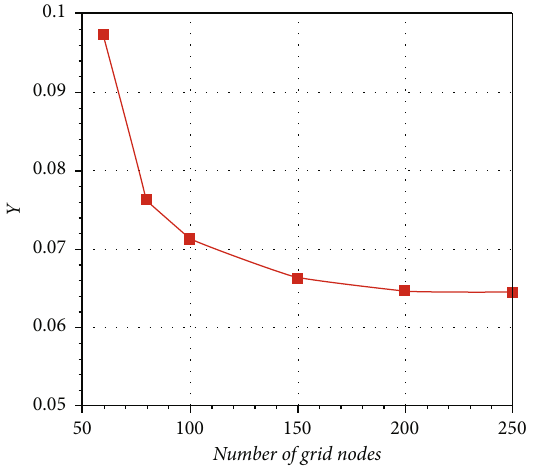
Figure 4: Mesh independence.